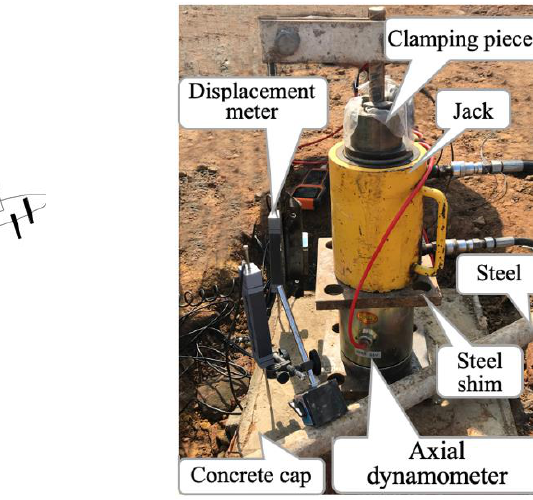
Figure 6. Test device. ( a ) Schematic diagram of the testing device ( b ) Field drawing of the testing device